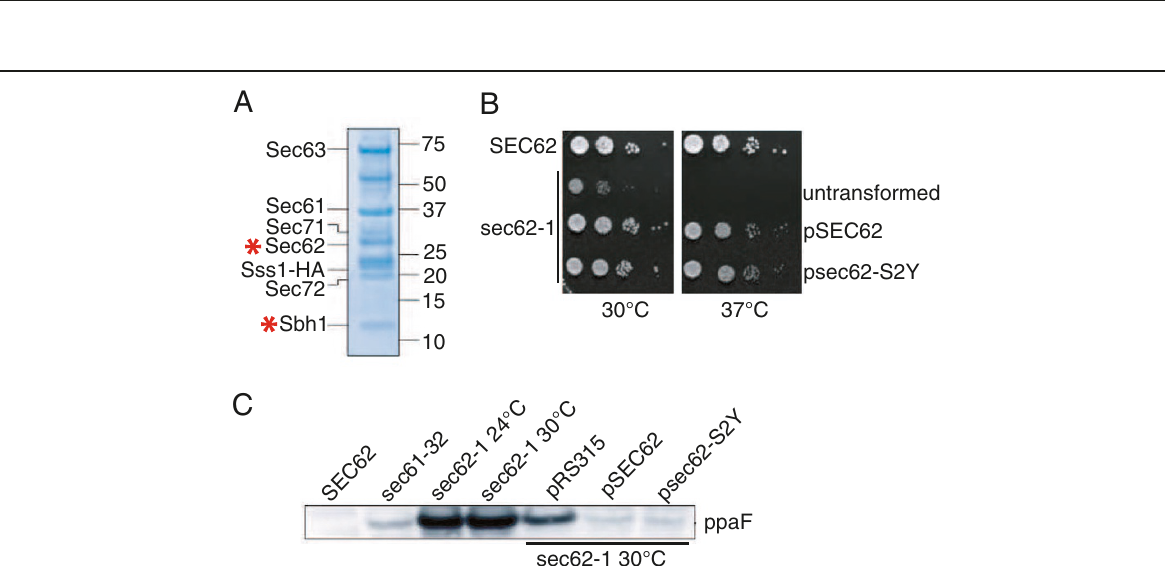
Figure 5 Sbh1p phosphorylation is dynamic. ( A ) SBH1 Δ sbh2 cells were labelled with [ 32 P]phosphate for 10 min and chased for the indicated times. Cells were lysed, Sbh1p and Sec63p immunoprecipitated, proteins resolved by SDS-PAGE and detected by autoradiography (upper panels) and immunoblotting (lower panels). Signals were quantified using a phosphorimager and relative amounts of protein (yellow) and phosphoprotein (blue) shown in the graphs. ( B ) N-termini of Sbh1p homologues were aligned.